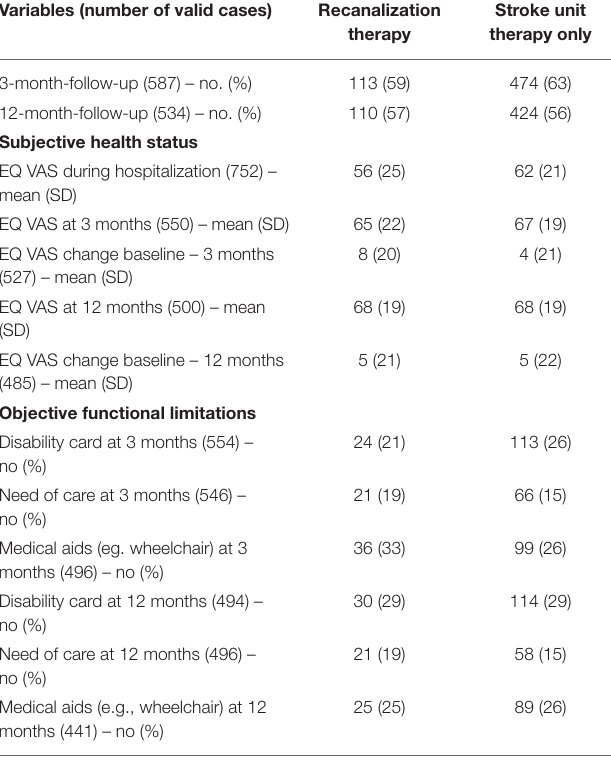
TABLE 2 | Association between stroke-specific acute therapies and patient outcome. Outcome* Effect estimate